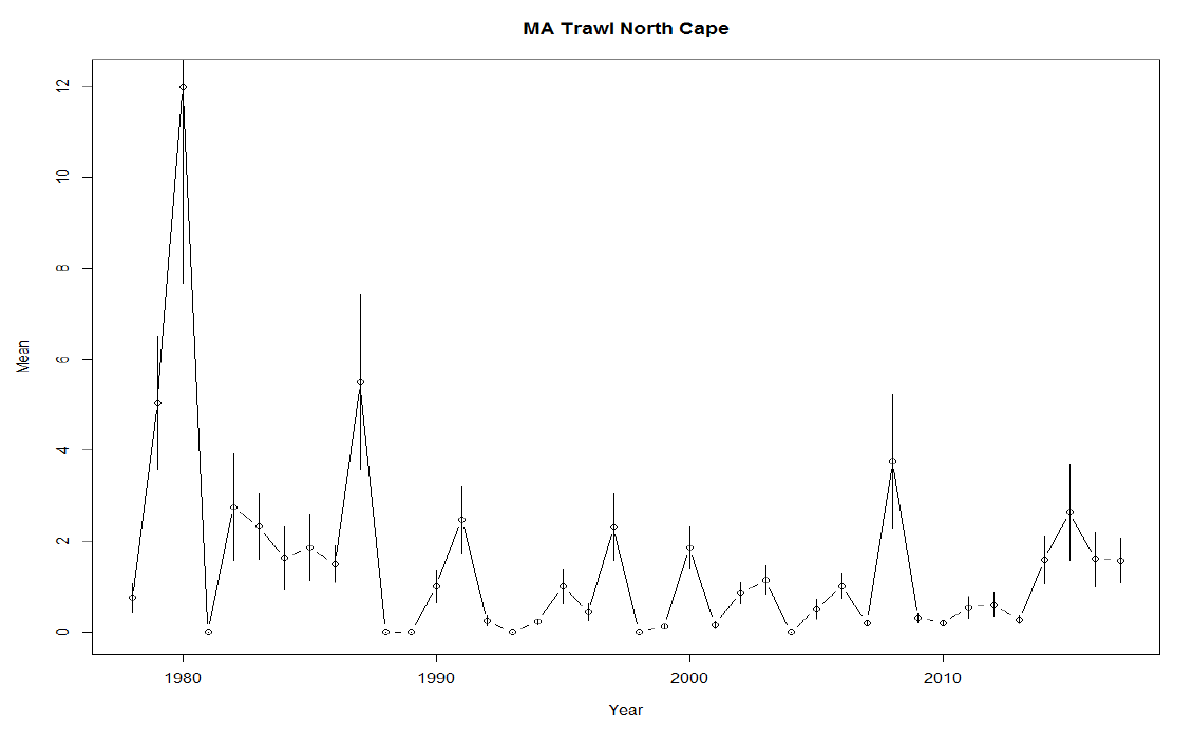
Figure 26. Index of relative abundance of horseshoe crab (delta mean catch per tow) developed from the fall portion of Massachusetts’ Resource Assessment Trawl Survey in strata north of Cape Cod with 95% confidence